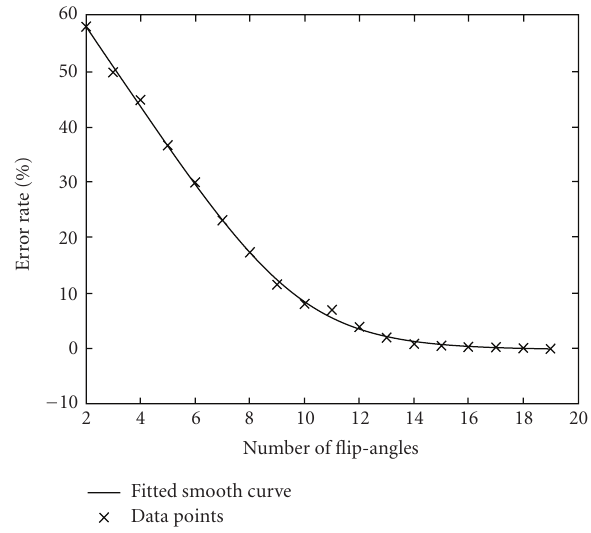
Figure 6: The error rate E versus number of flip angles, and 10 flip angles is at the inflection point of the fitted